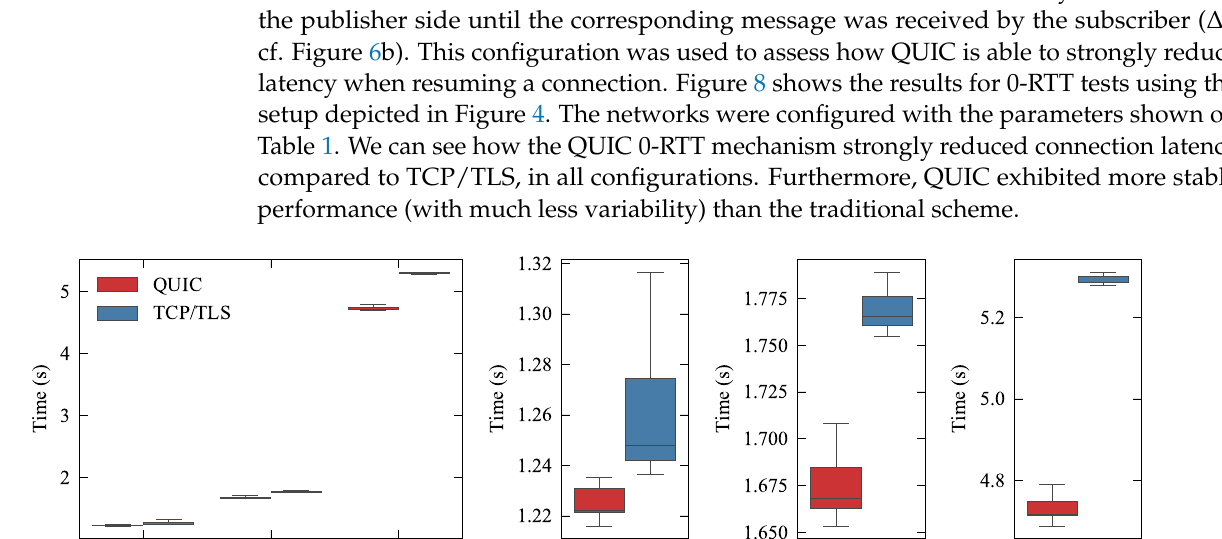
Figure 7. MQTT over QUIC and TCP completion times for traffic pattern A.